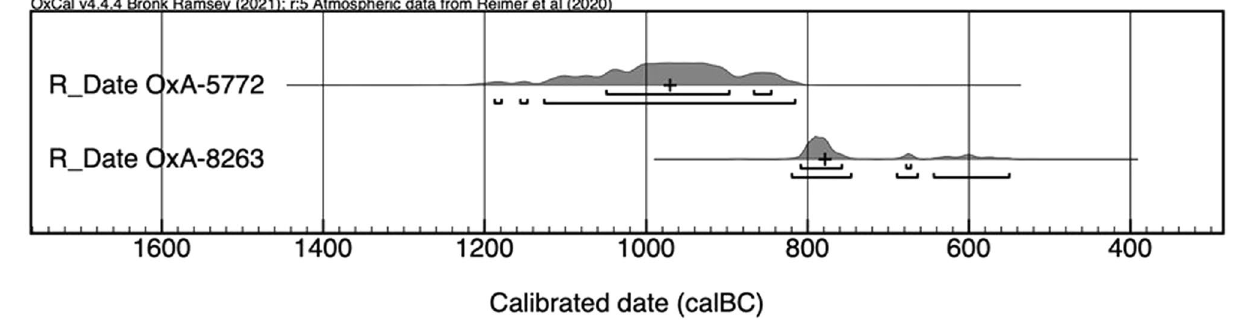
Figure 6. Calibration of the two samples for the trilobed container with OxCal v.4.4.4, and IntCal20 atmospheric